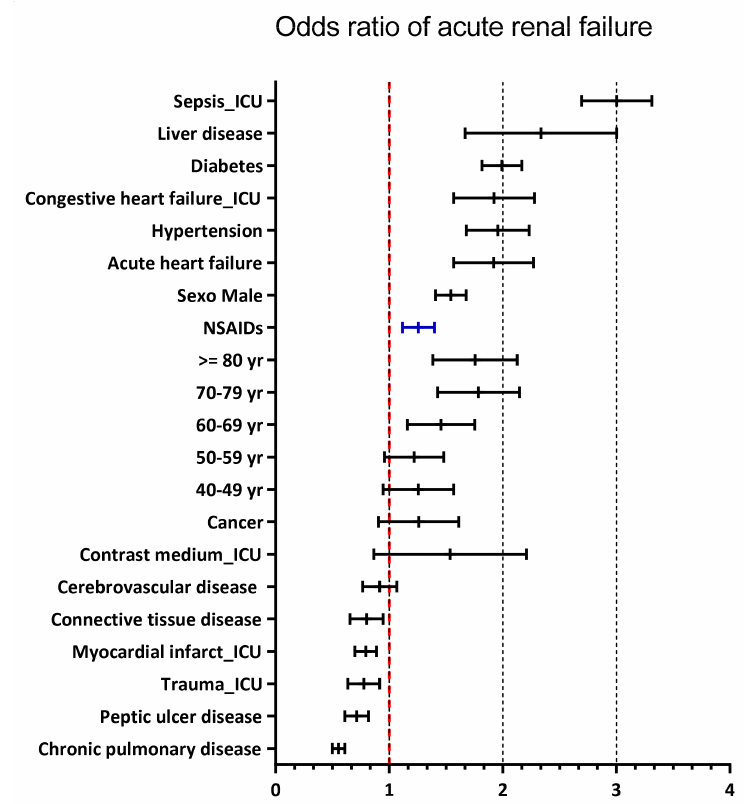
Figure 3. Factors for the development of acute kidney injury.